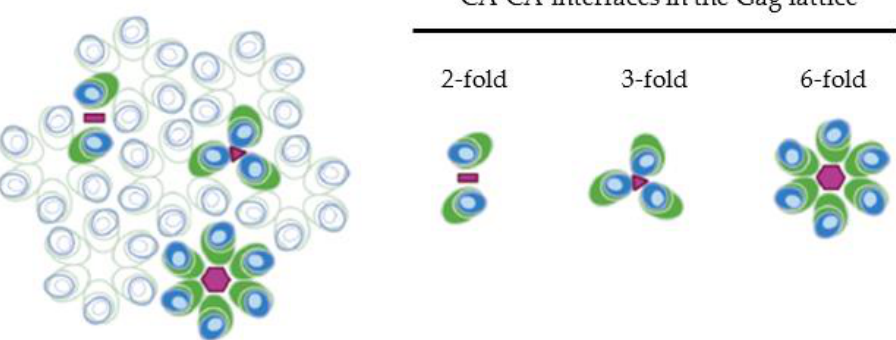
Figure 2. Organization of MA and CA in the membrane-bound Gag lattice. Gag domains are depicted as in Figure 1 but only MA and CA are shown. Blue, MA; light blue, HBR; and green, CA. Three types of CA-CA interactions contributing to formation of immature Gag lattice are shown on the right. The two-fold, three-fold, and six-fold interaction interfaces are denoted by pink bar, triangle, and hexagon, respectively. Six-fold interactions involving the MHR and six-helix bundle (formed by CA-CTD and SP1 regions) form Gag hexamer subunits, with interactions at the two-fold and two-fold interfaces binding adjacent hexamer rings to one another. In the immature lattice, MA trimers form above the two-fold CA interaction interface, with an MA domain presumably contributed from each of three adjacent hexamer rings.